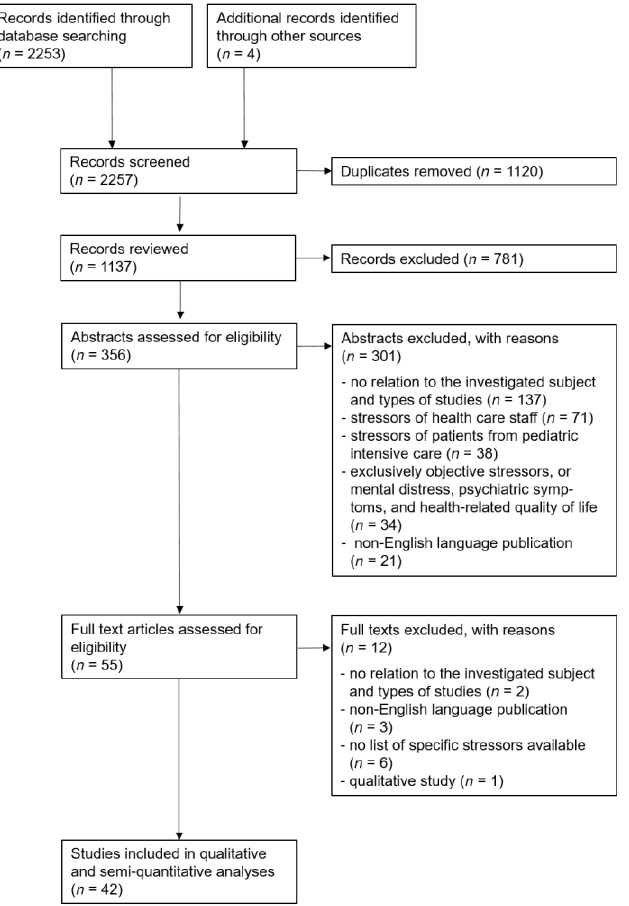
Figure 1. PRISMA flowchart.